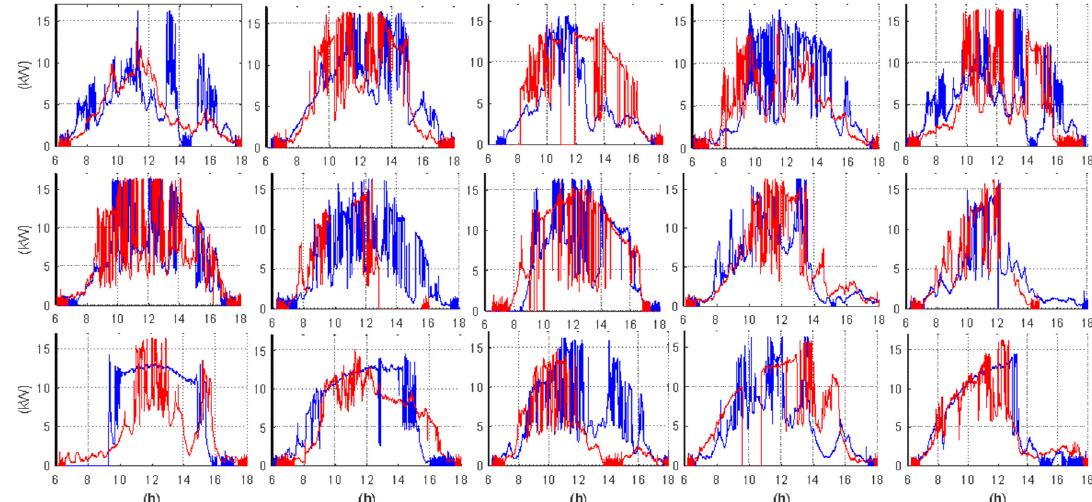
Figure 1. Daily solar irradiance, November 2018, Campus Balzay, Cuenca.